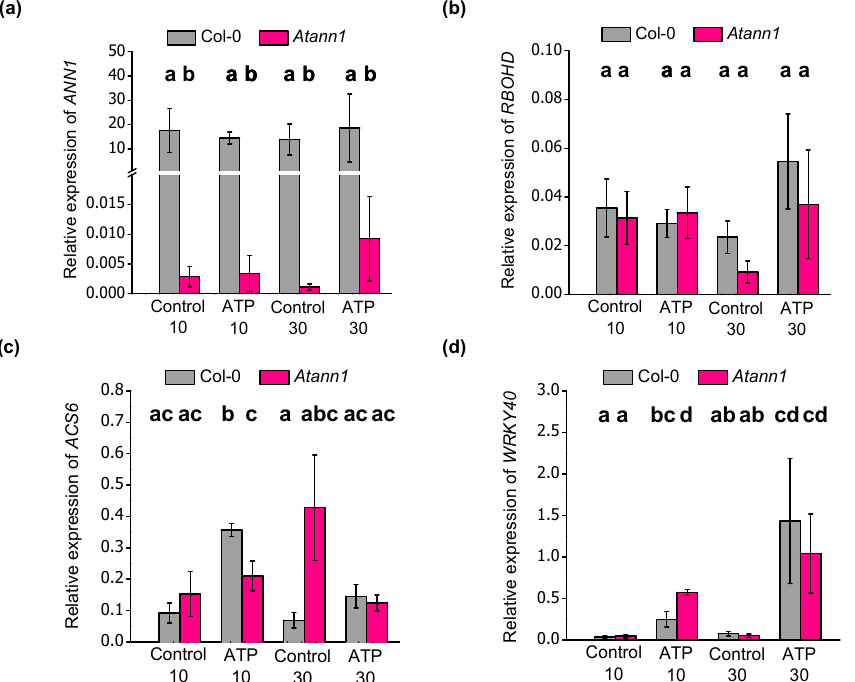
Figure 7. Transcriptional regulation of stress responsive genes by AtANN1. Col-0 and Atann1 whole roots were treated with control solution or 1 mM eATP for 10 or 30 min. Transcript abundance of ( a ) AtANN1 , ( b ) AtRBOHD , ( c ) AtACS6 and ( d ) AtWRKY40 normalised to two housekeeping genes; AtUBQ10 and AtTUB4 . Data were from the means (± SEM) of four independent trials. Student’s t -test and Welch’s t -test were used to test parametric data whereas Wilcoxon rank sum test was used for non-parametric data. Different lower-case letters indicate a significant difference between means ( p < 0.05).